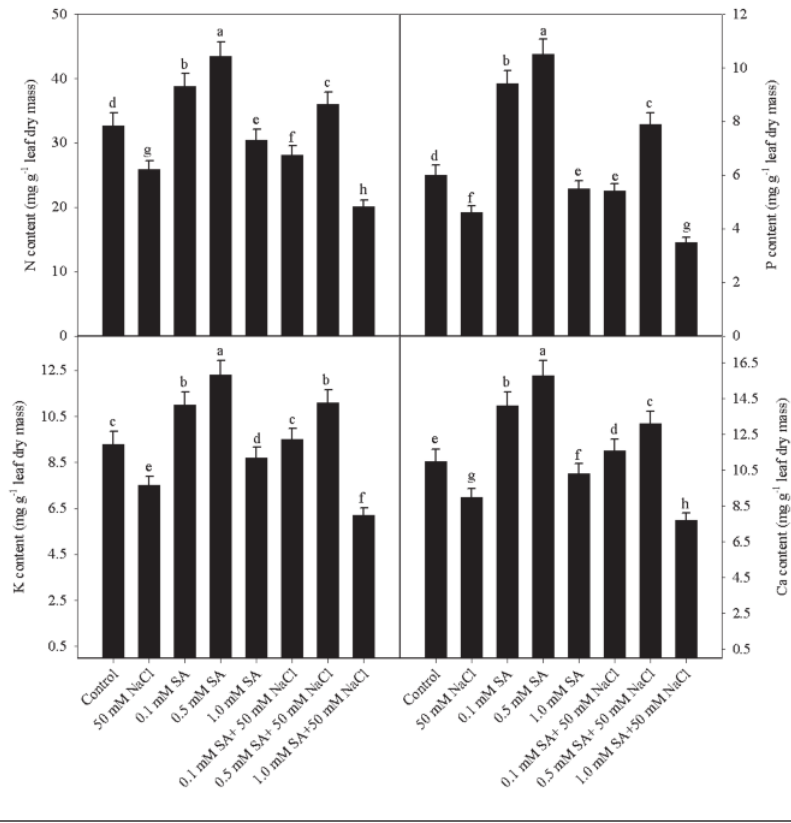
Figure 2. Effect of salicylic acid spray at 15 days after sowing (DAS) on N, P, K, and Ca content of mungbean ( Vigna radiata L.) plants grown with 0 or 50 mM NaCl at 30 DAS. Values are mean±SE. Data labeled by the same letter did not differ significantly at